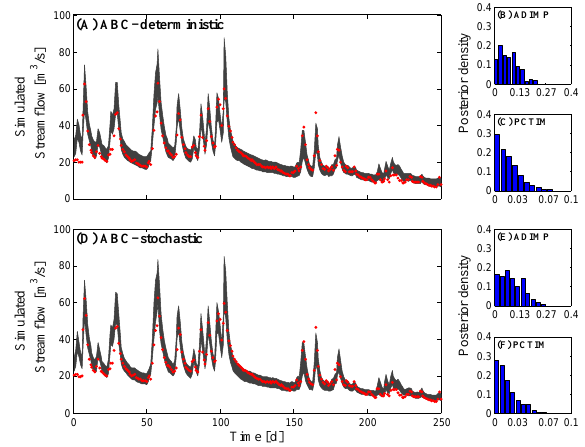
Fig. 14. SAC-SMA derived 95% streamflow simulation uncertainty ranges (grey region) for a three-year portion of the evaluation period of the Leaf River watershed using the (A) GLUE and (B) ABC de- rived posterior parameter distribution. The observed discharge data are indicated with the solid red dots.